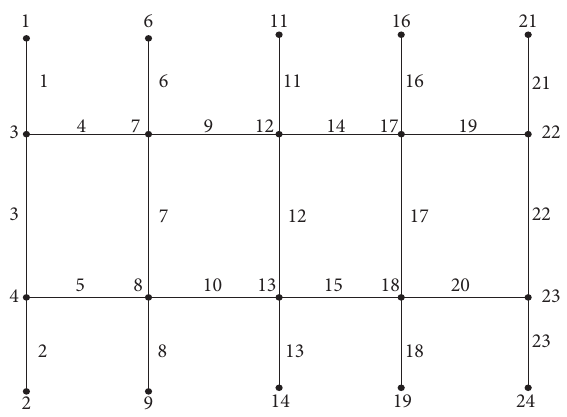
Figure 6: A classical mean labeling of L